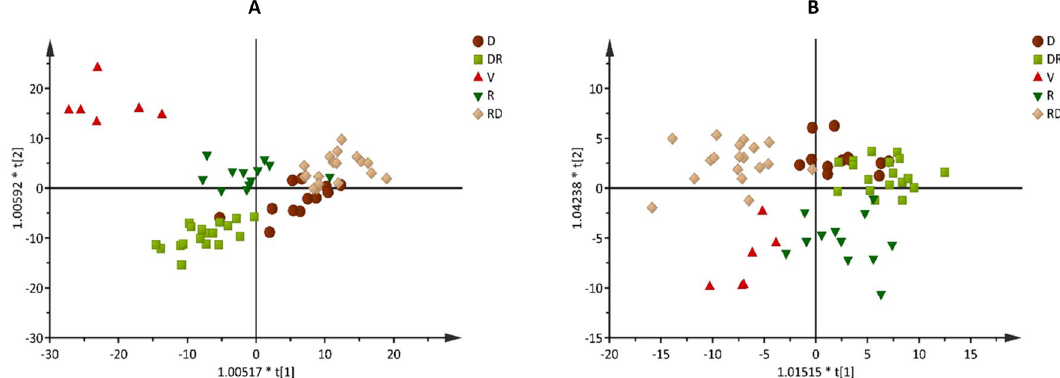
Figure 4. Multivariate data modelling: Score plot of orthogonal projection to latent structures discriminant analysis (OPLS-DA) performed on metabolites in leaves ( A ) and roots ( B ) of Gomphrena agrestis Mart. in a rock-field area in the dry and rainy seasons. Sample groups: D dry period, RD transition from dry to rainy period, V veranico period, R rainy period, RD transition from rainy to dry